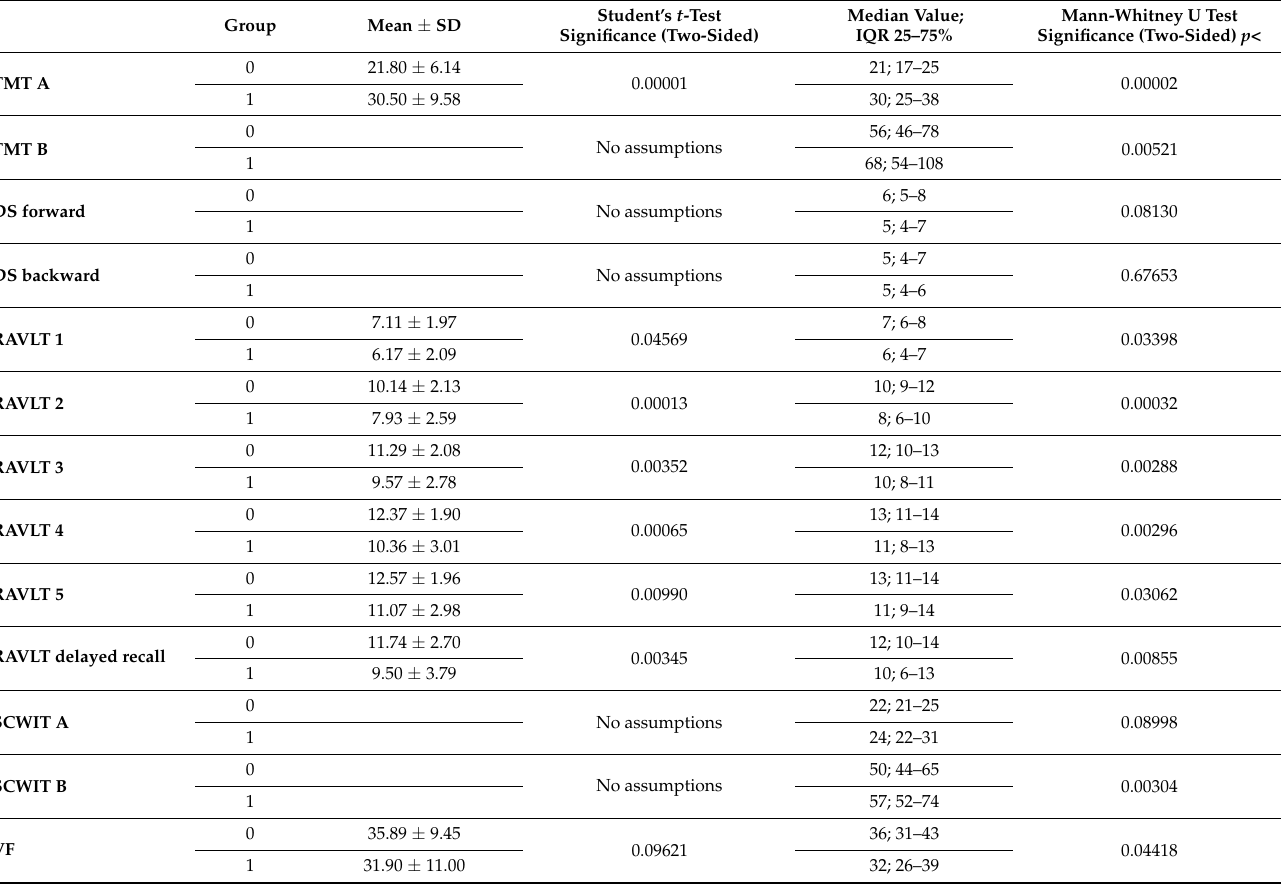
Table 1. The results of neuropsychological tests in healthy controls (group 0; N = 36) and patients with psoriasis (group 1; N = 53). The mean values, standard deviations and significance of differences between groups are also